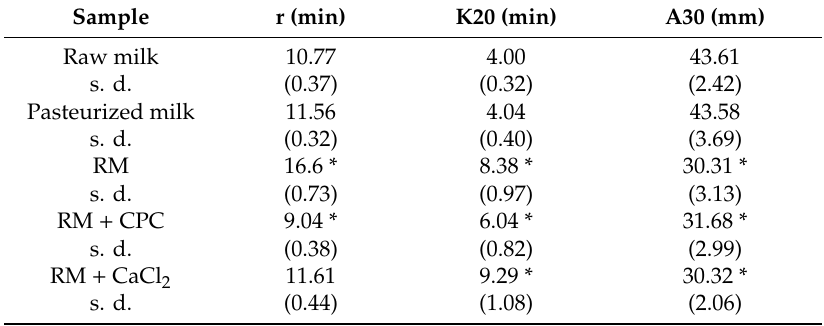
Table 2. Renneting properties of the recombined milk (RM) reconstituted at the same protein and fat content of fresh raw milk and used alone or with the addition of 0.1 g / L CaCl 2 or 1 mL / L colloidal calcium phosphate (CPC). Raw and pasteurized liquid milk were used as controls.